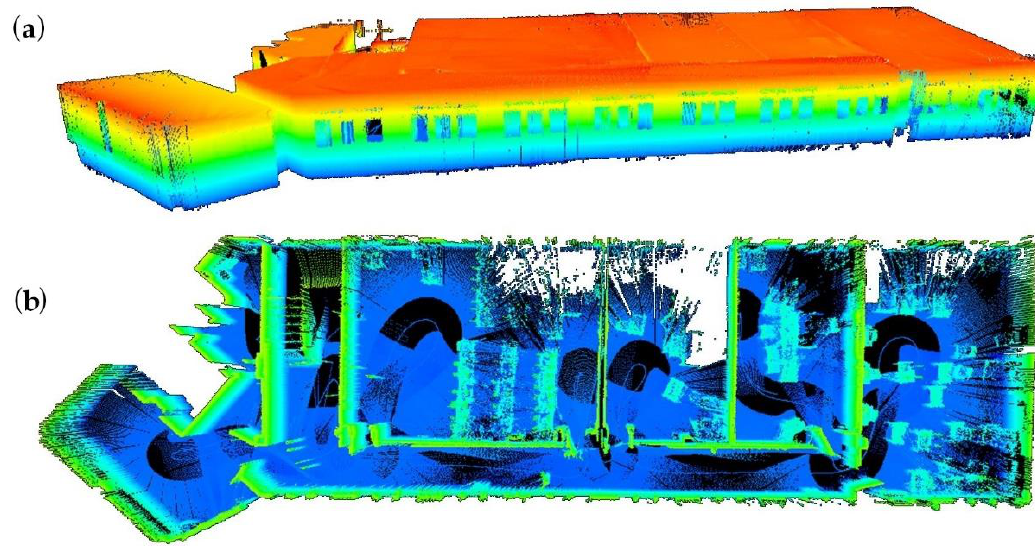
Figure 5. Building 3D point cloud acquired with the IMAS: ( a ) walls and floors in the perspective view; and ( b ) the whole point cloud in perspective.